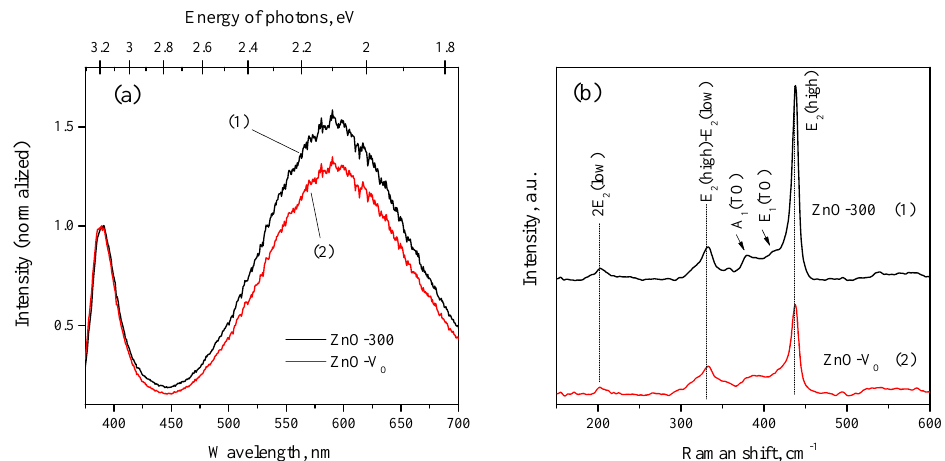
Figure 7. ( a ) Normalized PL spectra of ZnO-300 (1) and ZnO-V O (2) samples at RT (excitation wavelength 360 nm); ( b ) Raman spectra of ZnO-300 (1) and ZnO-V O (2) samples at RT (excitation wavelength 785 nm).